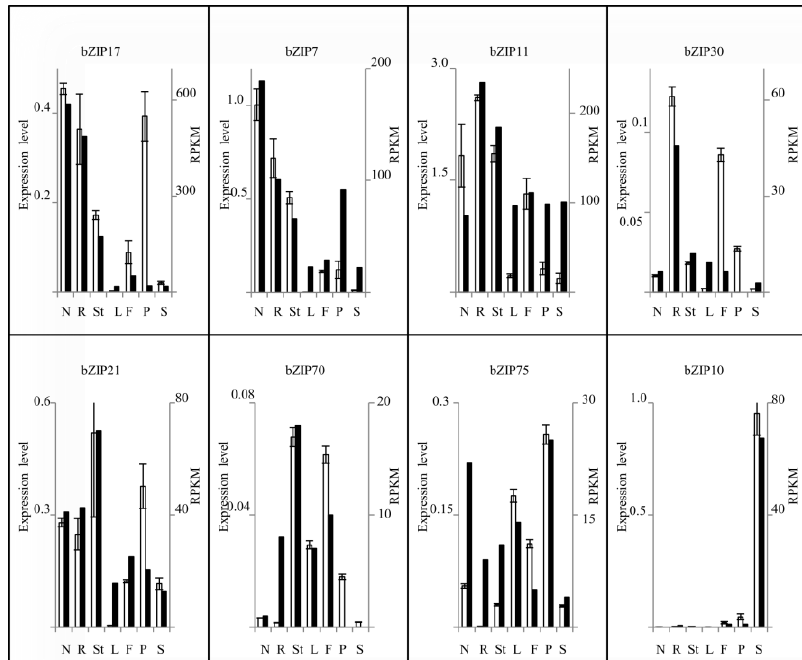
Figure 2. Expression level comparisons of quantitative reverse-transcriptase-PCR (qRT-PCR) and RNA-seq results for selected PvbZIP genes. For qRT-PCR expression analysis tissues were obtained from common bean plants (cultivar Negro Jamapa 81) grown under conditions like those used for transcriptomic analysis [16]. N: Nodule; R: Root; St: Stem; L: Leaf; F: Flower; P: Pod; S: Seed. White bars refer to relative expression level determined by qRT-PCR, based on cycle threshold (Ct) value normalized with the expression of the housekeeping UBC9 gene. Values represent the average ± SD from three biological replicates. Black bars refer to reads/Kb/Million (RPKM) values from the RNA-seq analysis available at the Pv _GEA (http://plantgrn.noble.org/pvGEA/).